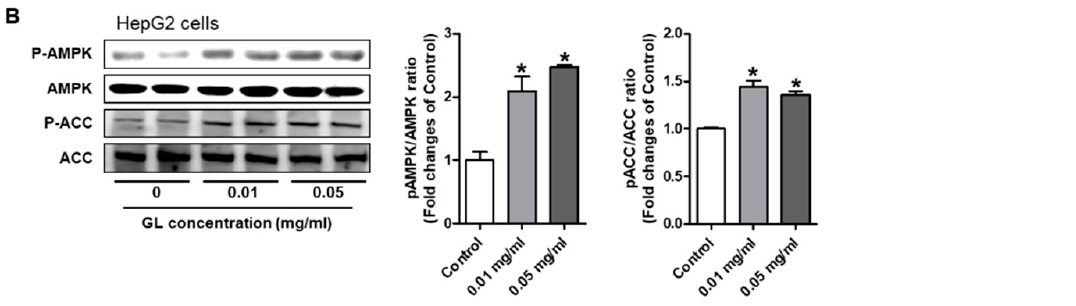
Figure 6. GL induced AMPK and ACC phosphorylation and GLUT4 protein expression in 3T3-L1 and HepG2 cells. Representative band images of western blot analysis and densitometric quantifications of relative band intensities in ( A ) 3T3-L1 and ( B ) HepG2 cells. GL (0.01 and 0.05 mg/mL) or vehicle was treated in the 3T3-L1 and HepG2 cells and protein levels were analyzed using Western blot. Data are the means ± SEM from three independent experiments. * p < 0.05 vs. control group (0 mg/mL concentration).